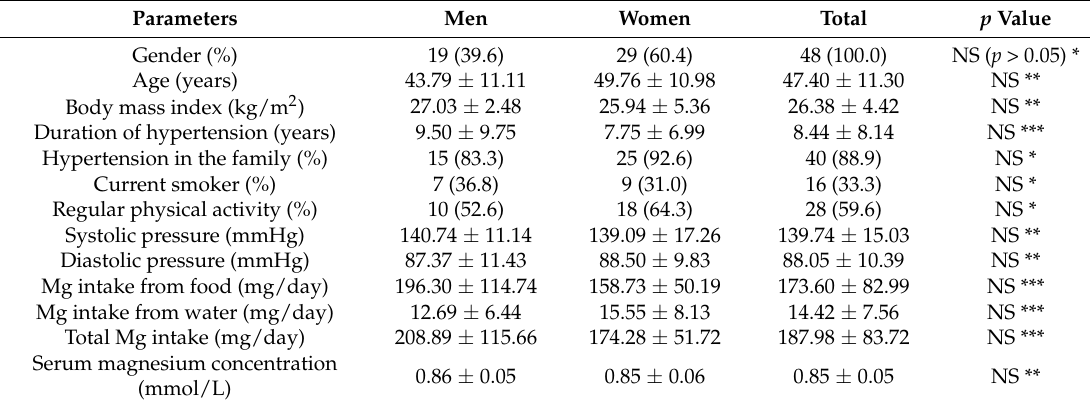
Table 1. Baseline characteristics of the investigated population by gender.